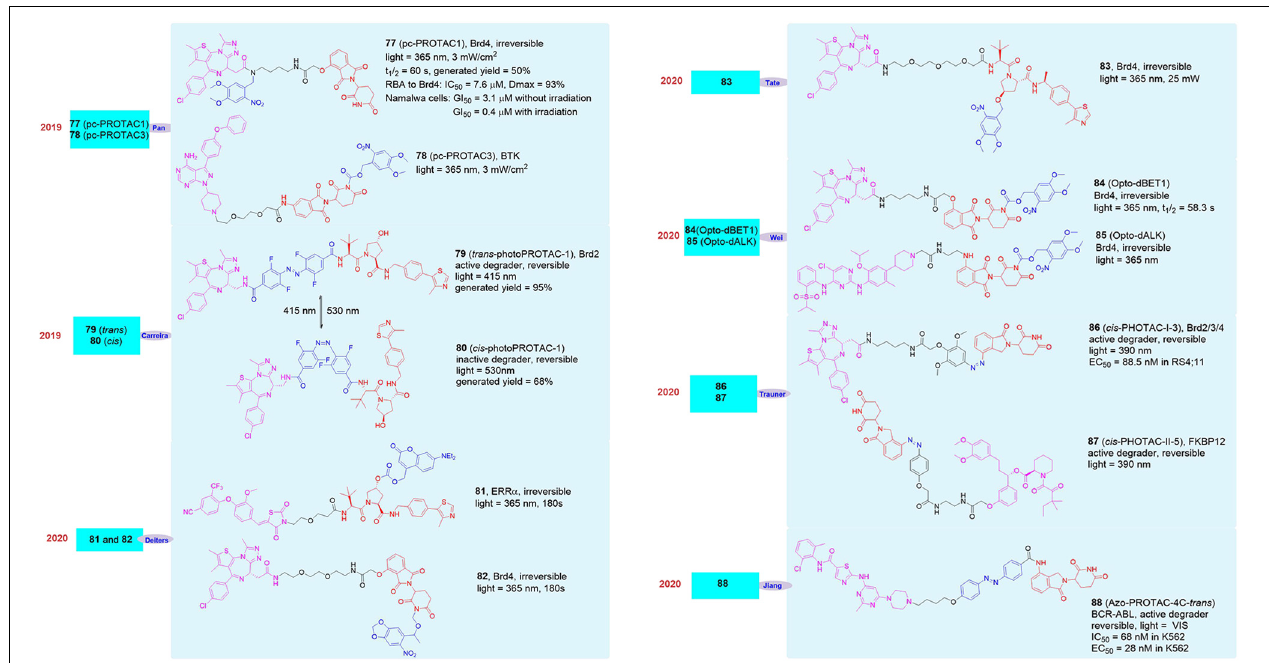
FIGURE 14 | Structures of optical control